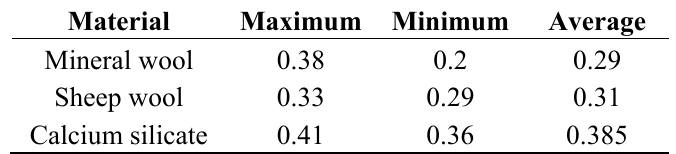
Table 5. Impact of seasonal moisture content variations on of the change of U-values (W/m 2